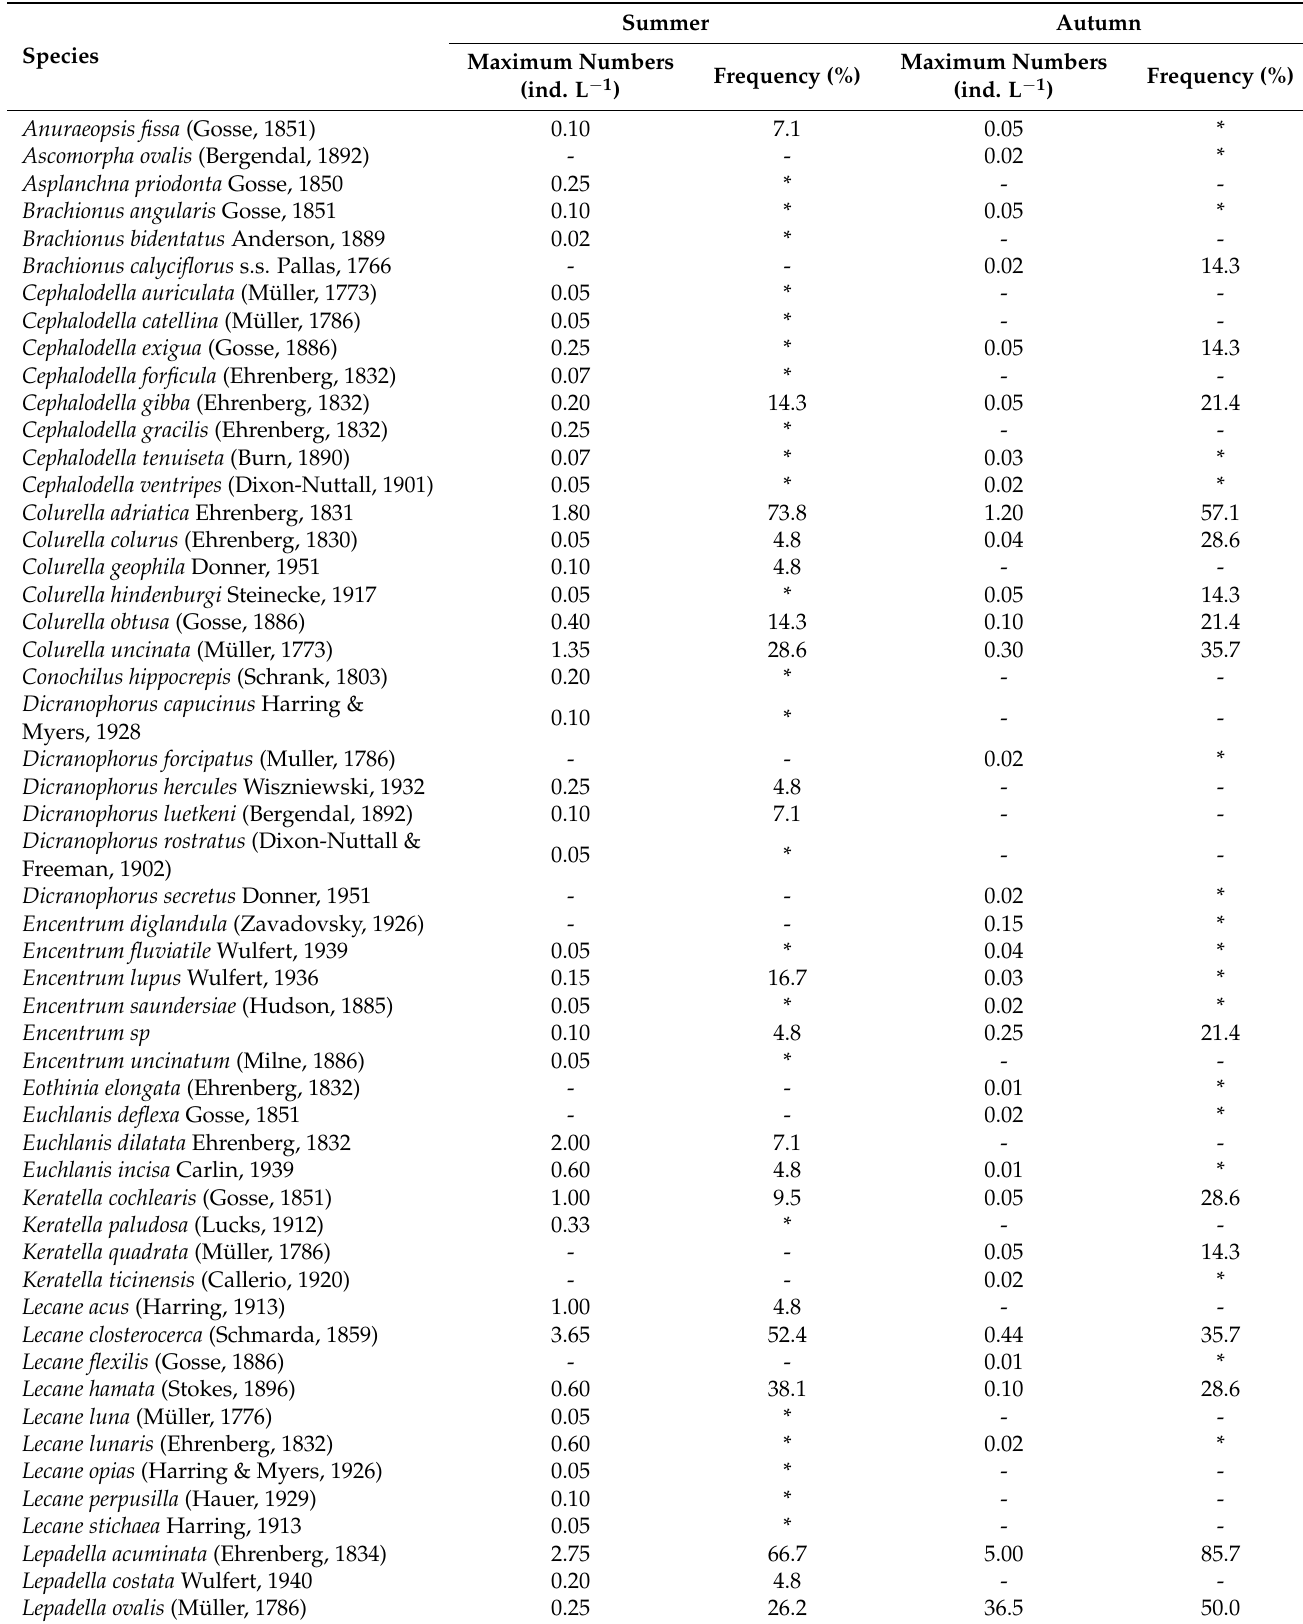
Table 3. A list of rotifer species. their maximum abundance and frequency in the springs of the Knyszyn Forest; single observations are marked with stars (*); Supplementary